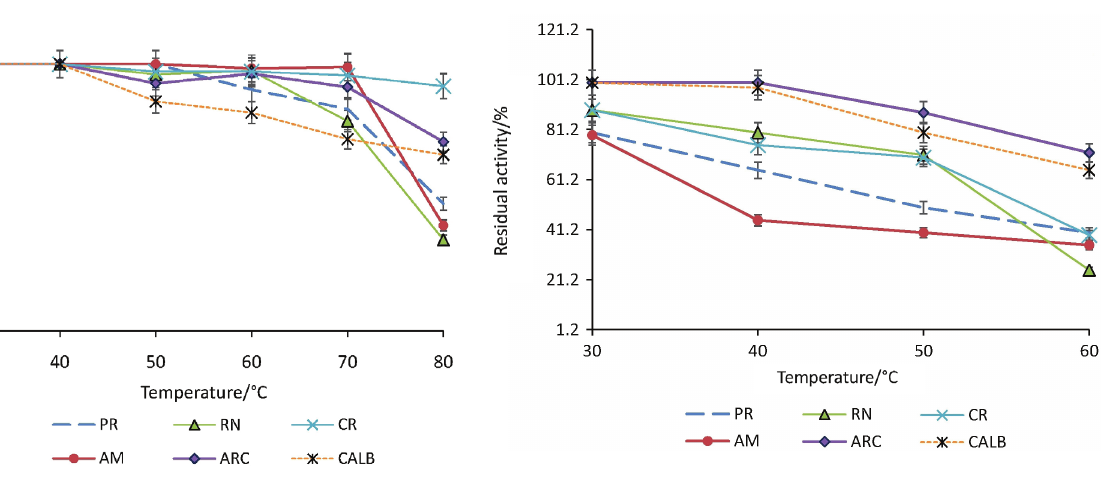
Fig. 4a – Activity of lipases at different temperatures (incu- bation in buffer solution)